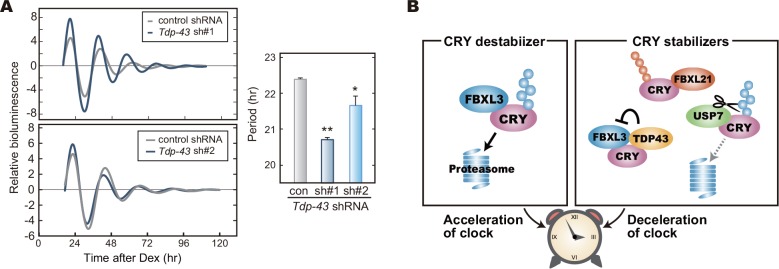
Tdp-43 knockdown shortens the circadian period.A. Cellular rhythms in Tdp-43 knockdown cells. Bioluminescence rhythms of Bmal1-luc reporter were recorded as described in Fig 4A. Calculated periods of the cellular rhythms are shown as means + SEM (n = 4, *: p < 0.05, **: p < 0.01 by Student’s t-test). B. A model for period-determination by the control of CRY proteins stabilities. CRY protein destabilizer, FBXL3, accelerates the oscillation of the circadian clock, while CRY stabilizers slow down the oscillation speed.